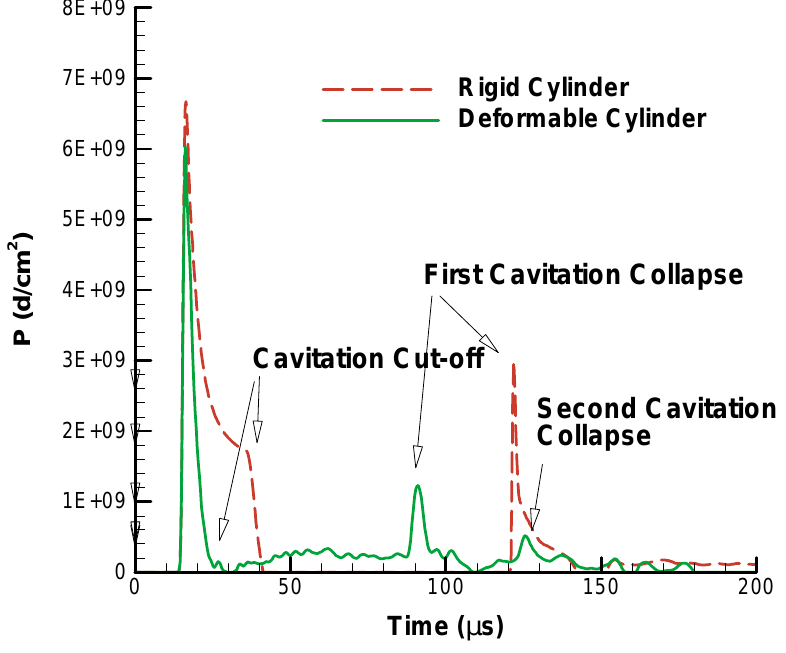
Fig. 8. Inner wall pressure histories for the deformable and rigid cylinder cases.